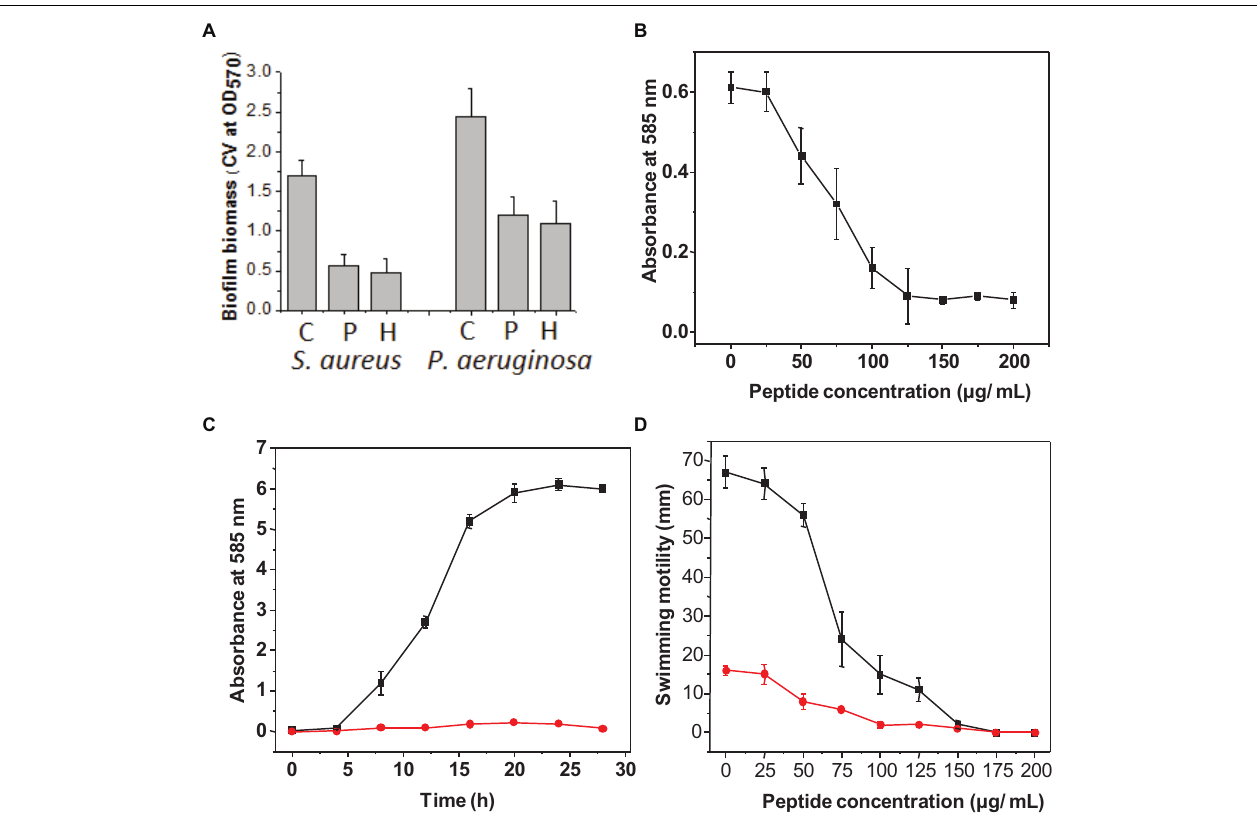
FIGURE 5 | Assay of biofilm formation after staining with crystal violet stain (A) . Bar graph indicates the biofilm formation of S. aureus and P. aeruginosa treated with only curd (C) , biofilm formation when treated with extracted peptide (P), and treated with hydrogel (H). The concentration used was 32 µ g ml − 1 . Violacein production by the strain C. violaceum treated with different concentrations of peptide (B) . Violacein production by the strain C. violaceum in batch culture grown with (red line) and without (black line) peptide (C) . Assay of swarming motility was evaluated on LB agar plates treated with different concentrations of hydrogel (D) . The diameters (in cm) of the swim zones were measured after incubation for 20 h at 37 ◦ C. The swim motility was studied in medium supplemented with different concentrations (0–200 µ g ml − 1 ) of hydrogel against both strains, with S. aureus indicated by the red line and P. aeruginosa indicated by the black line. All experiments were done in triplicate. Data are the mean of triplicates ±